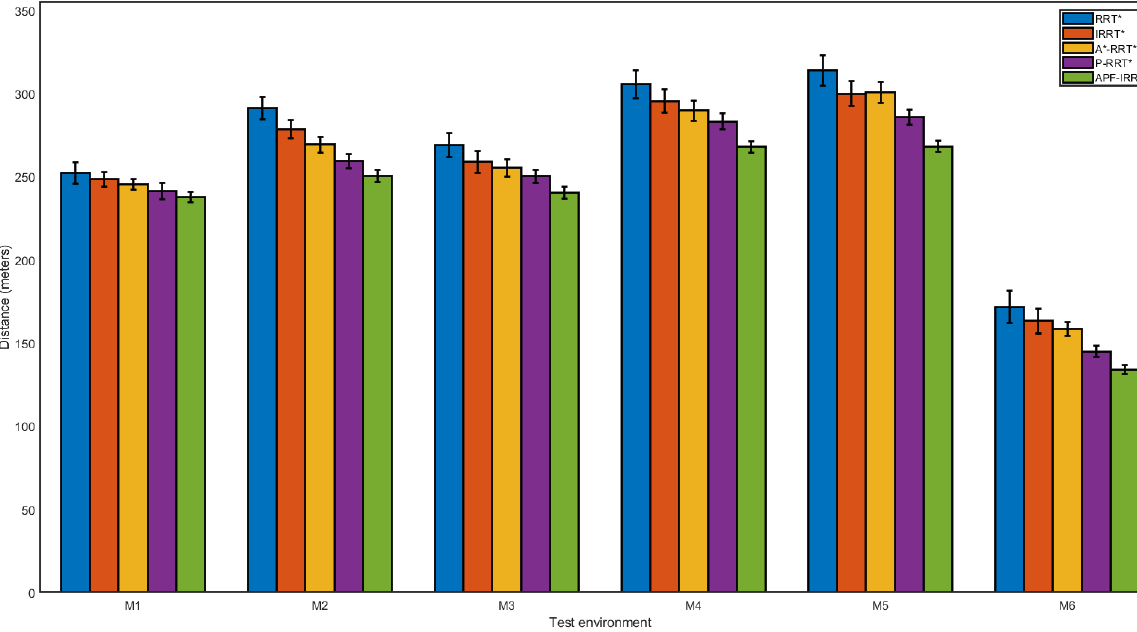
Table 2. The mean value of search time for 20 independent simulations of RRT*, IRRT*, A*-RRT*, P-RRT*and APF-IRRT* algorithms.